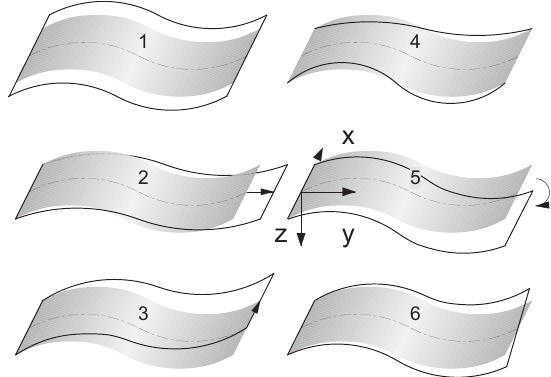
Figure 2: Load cases illustration (after